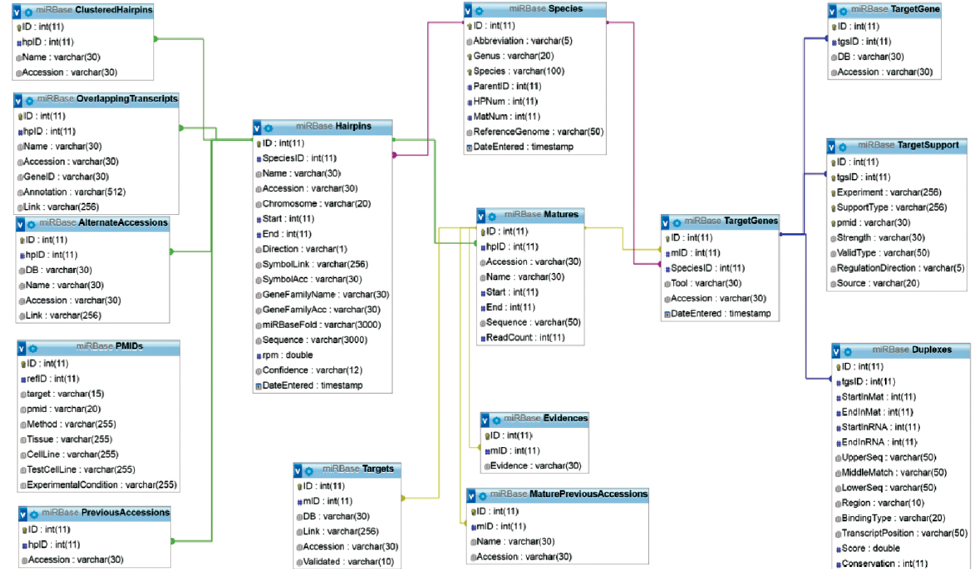
Figure 1: Schema of the integrated miRNA database for VANESA. Our miRNA database was curated from miRBase, Tar- Base, and miRTarBase data. Figure shows tables, fields and relationships within the database